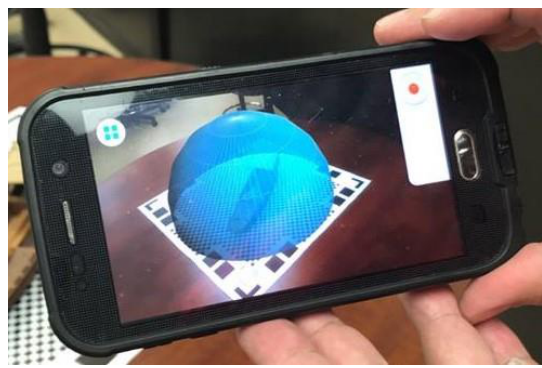
Figure 5. Qlone Model of Small Junk